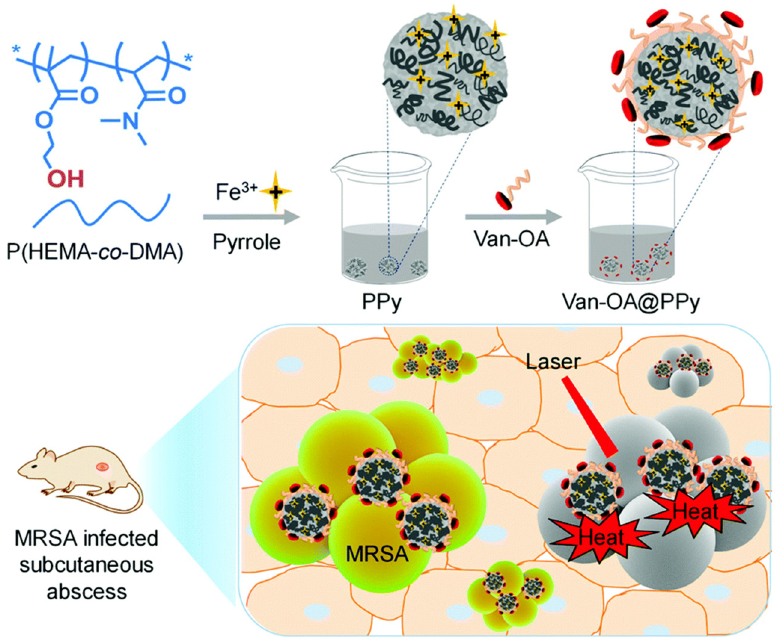
Figure 8. Schematic illustration for in situ formulation of pathogen-targeting phototheranostic nanoparticles, Van-OA@PPy, for photothermal inhibition of MRSA infection. P(HEMA-co-DMA) was employed as a template to afford PPy in situ in the presence of Fe 3+ , and then PPy was further self-assembled with vancomycin-tethered oleic acid (Van-OA) to afford the resultant phototheranostic Van-OA@PPy. [183]. Copyright 2020 Nanoscale.